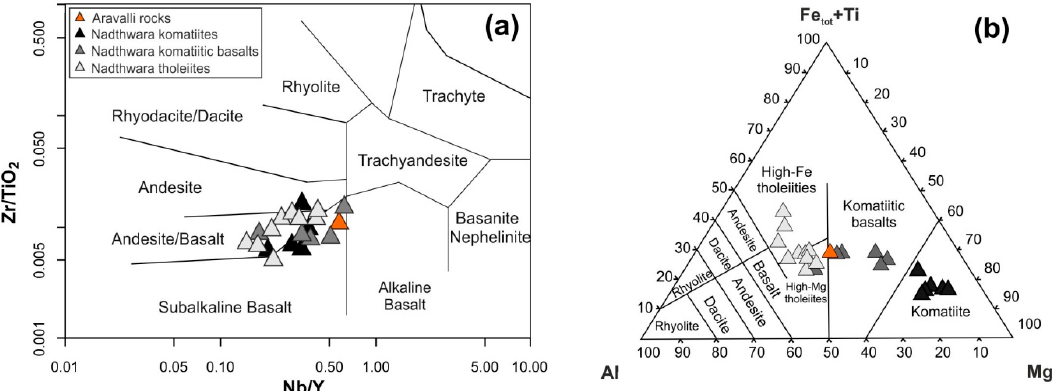
Figure 9. ( a ) Zr/TiO 2 vs Nb/Y plot after [41], ( b ) Al-(Fe tot + Ti)-Mg diagram after [42] for the AR-6C Figure 9. ( a ) Zr / TiO 2 vs Nb / Y plot after [41], ( b ) Al-(Fe tot + Ti)-Mg diagram after [42] for the AR-6C sample and Nathdwara volcanic rocks (data from [10]). sample and Nathdwara volcanic rocks (data from [10]).